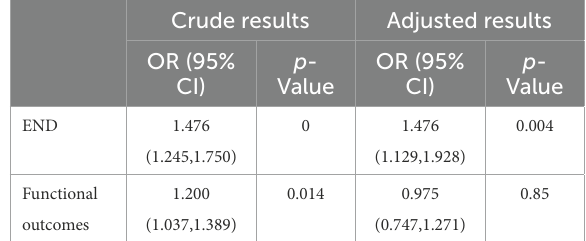
TABLE 3 Logistic regression analysis showing the impact of HbAlc on END and functional outcomes in acute mild ischemic stroke patients treated with intravenous